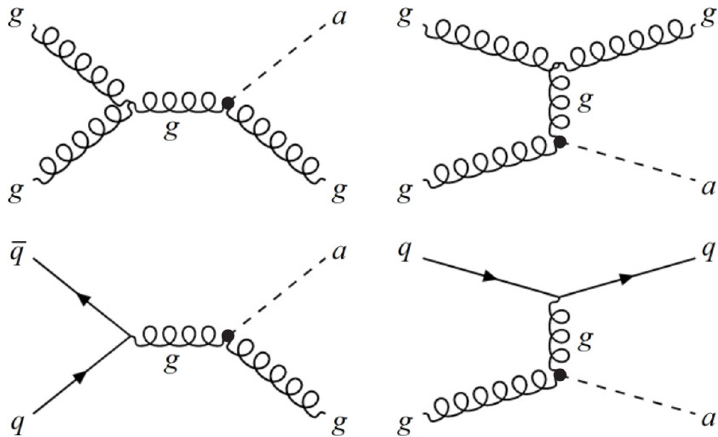
Figure 1 . Representative production processes of ALPs in association with a jet at pp colliders ( p p → a j ) when only ALP’s coupling to gluons is considered.